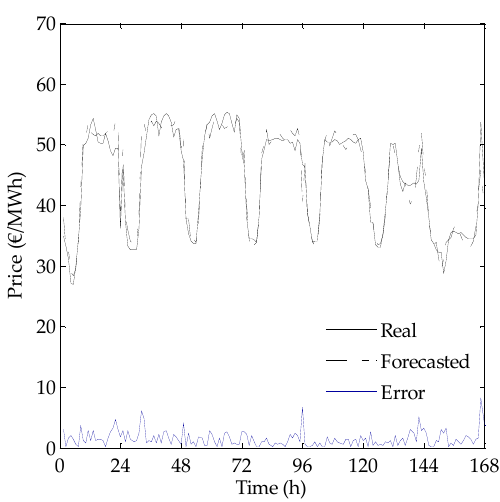
Figure 6. Spring week 2002 results for the Spanish market.